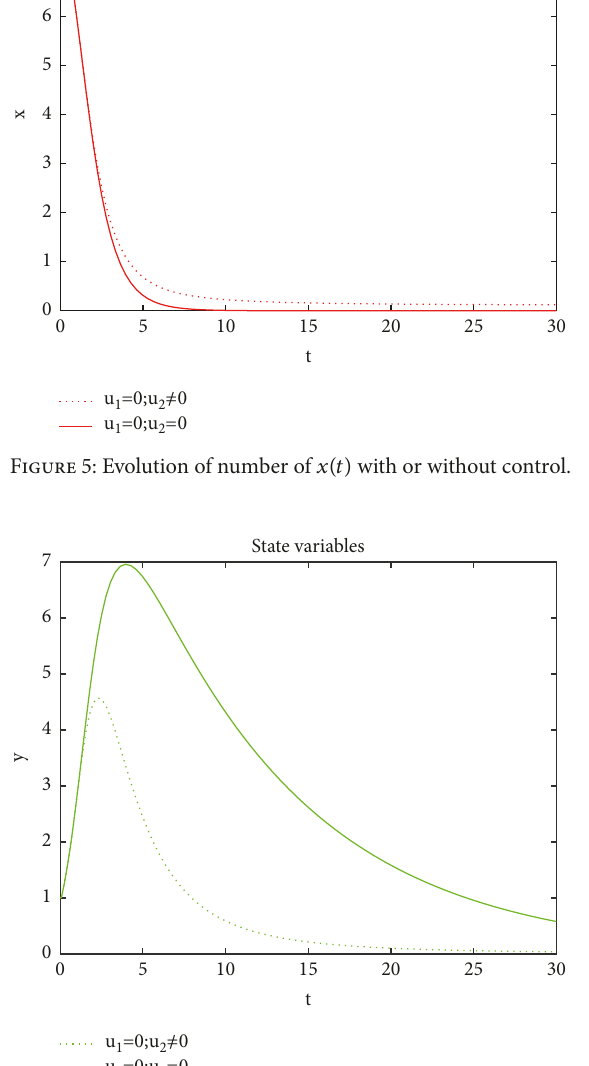
with and without control is shown in Figures 5 , 6, and 7 .